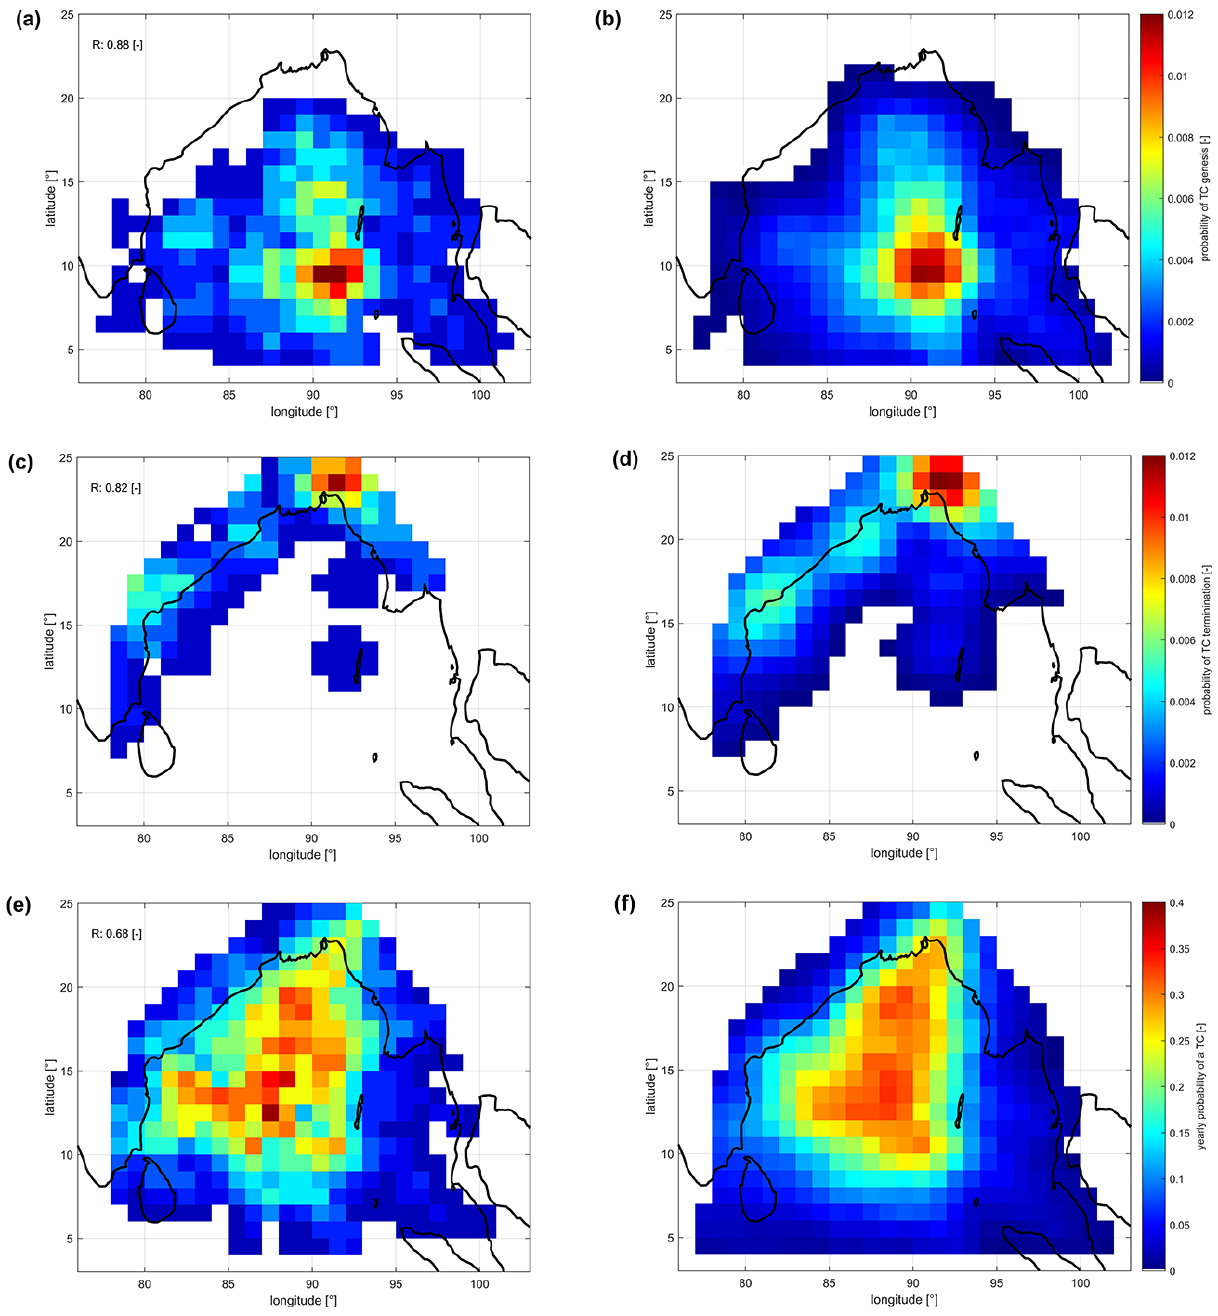
Figure B1. Probability of TC genesis: (a) historical and (b) synthetic. Probability of TC termination: (c) historical and (d) synthetic. Yearly probability of a passing TC: (e) historical and (f) synthetic (STCC). Indicated error statistic is the correlation parameter R based on Kirchhofer